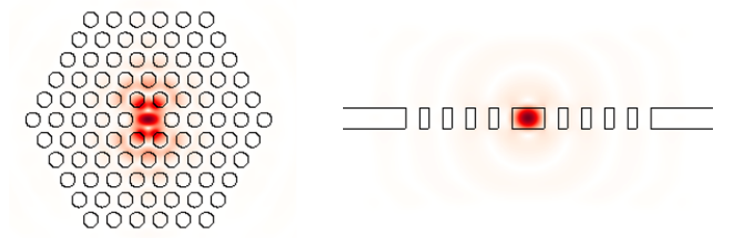
Figure 6. Mode profiles |E| of H1 2D photonic crystal microcavity.